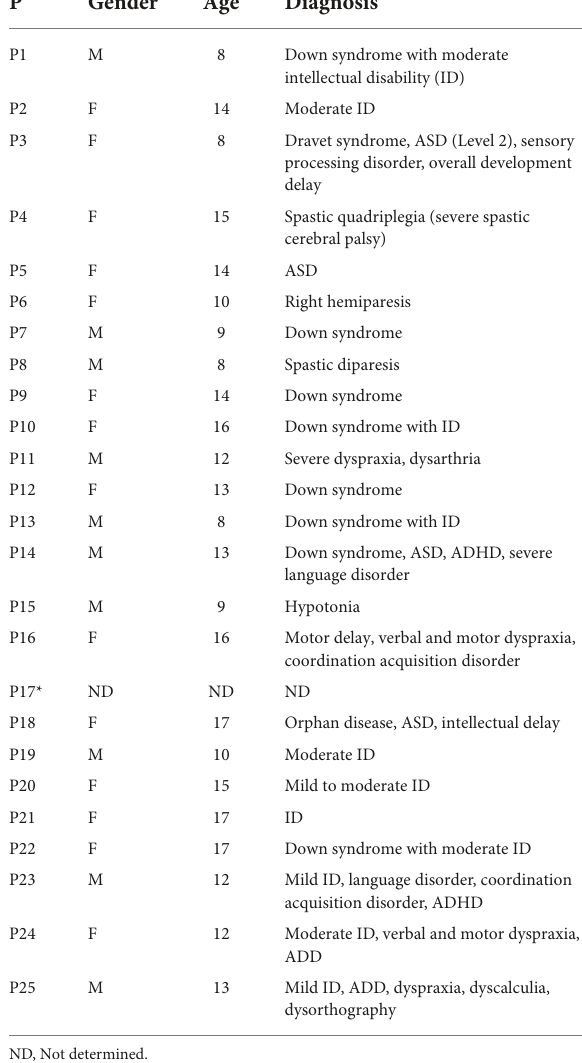
TABLE 1 Sociodemographic data for